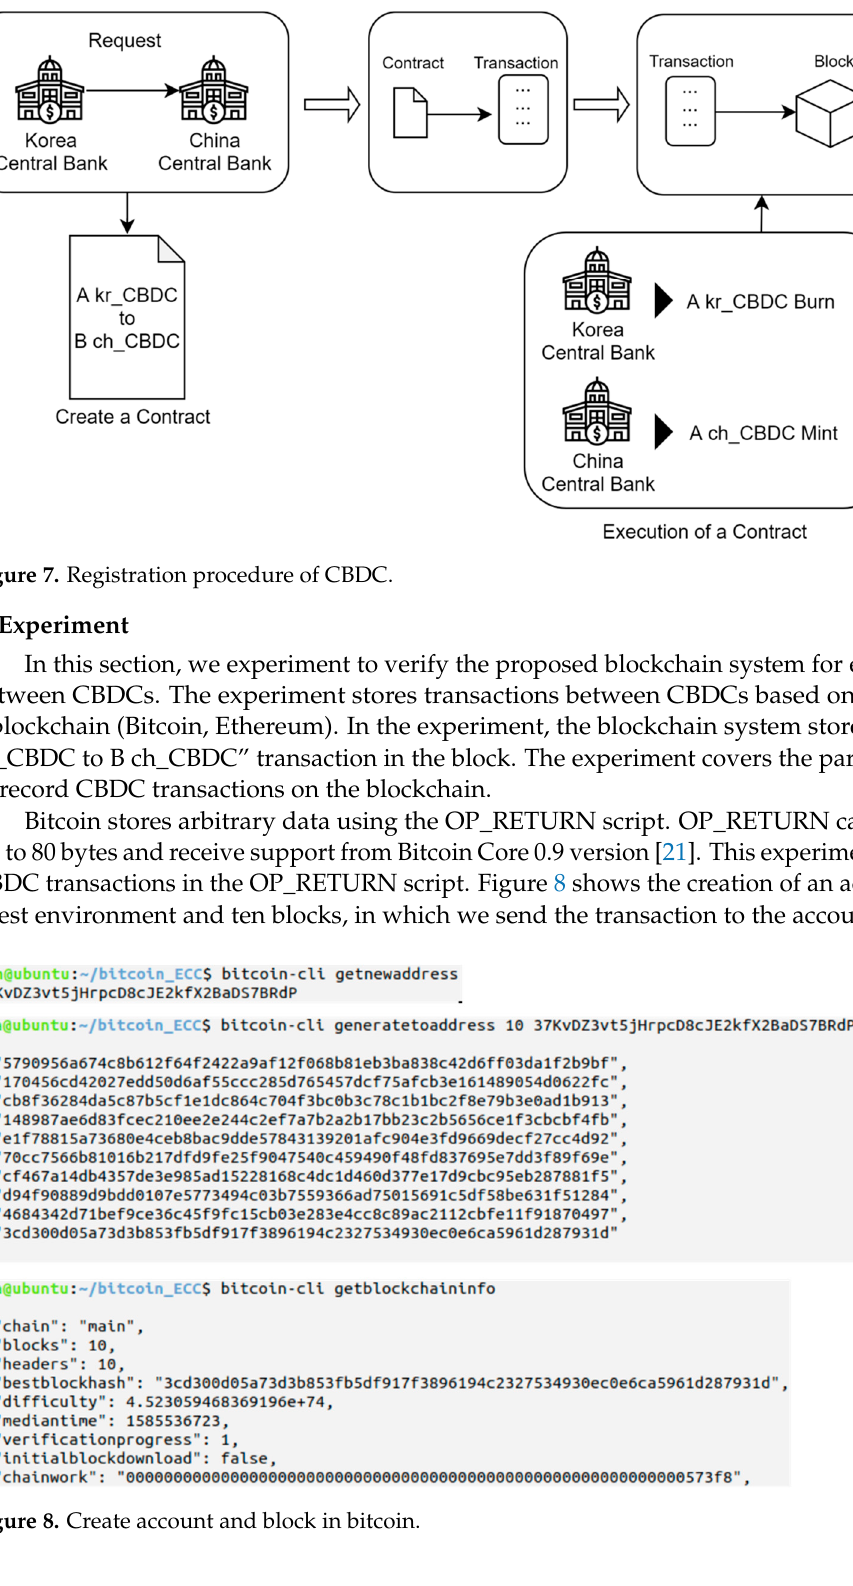
Figure 9. Convert input data to Hex. Figure 10 shows creating a raw transaction that stores the OP_RETURN value converted to a Hex value. We choose “txid” to make the transaction and create a raw transaction. Additionally, Then, we search the account’s UTXO (Unspent transaction output) with the “listunspent” command. Raw transactions are created using the “createrawtransaction” command. The raw transaction is created using the searched txid and Hex.